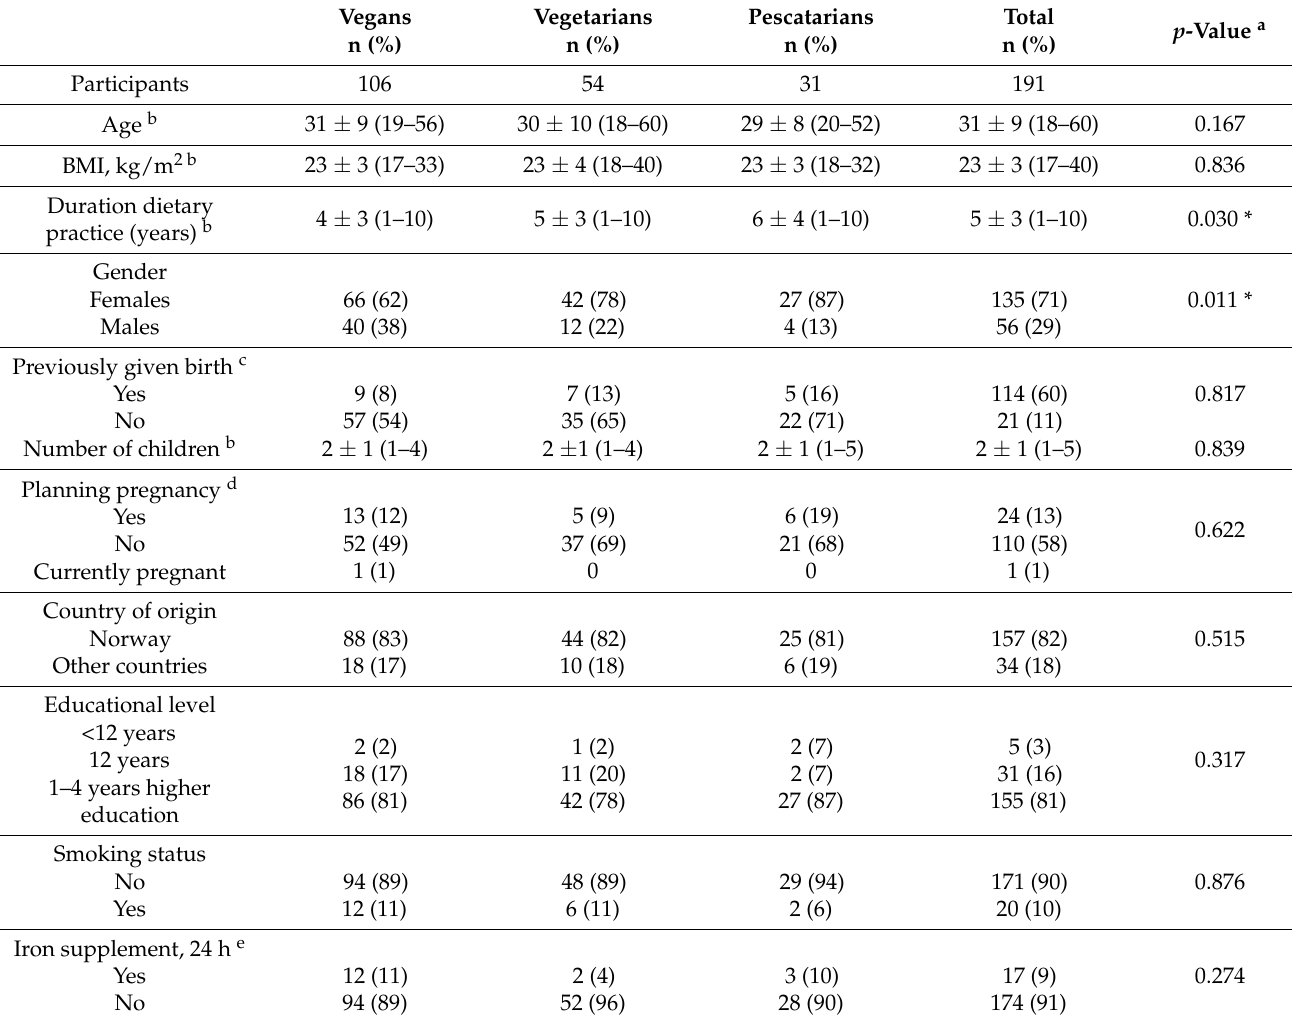
Table 1. Background characteristics of vegans, vegetarians and pescatarians in Norway ( n =